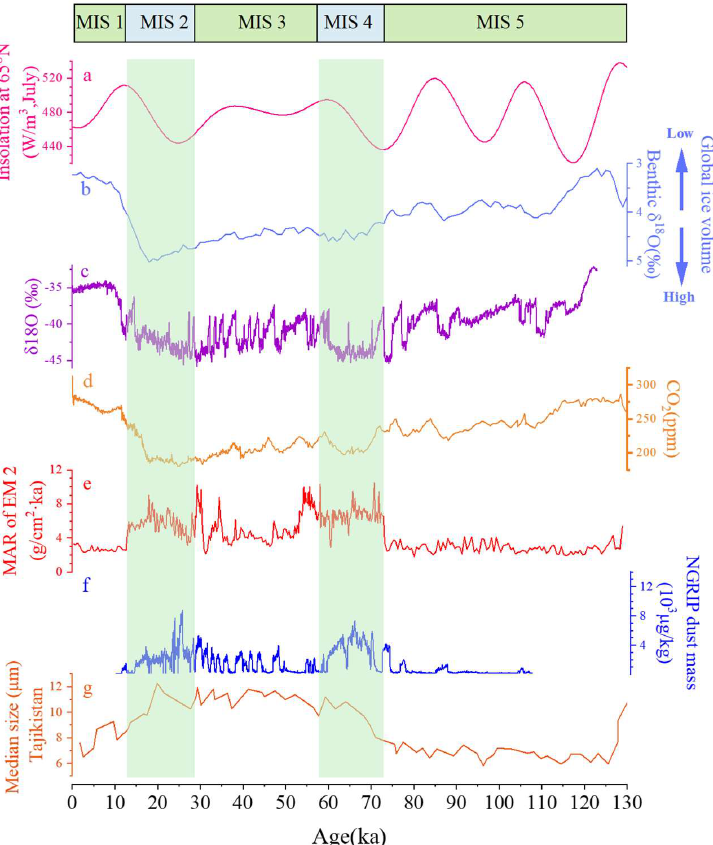
Figure 6. ( a ) July insolation at 65 ◦ N in the Northern Hemisphere [78]; ( b ) the LR04 benthic δ 18 O record [79]; ( c ) the GISP δ 18 O record of Greenland ice [80]; ( d ) atmospheric CO 2 record from Antarctica [81]; ( e ) mass accumulation rate (MAR) of EM2; ( f ) dust mass concentrations from NGRIP ice core [74]; and ( g ) median grain size of the Chashmanigar section in Tajikistan [66]. MIS: marine isotope stages.